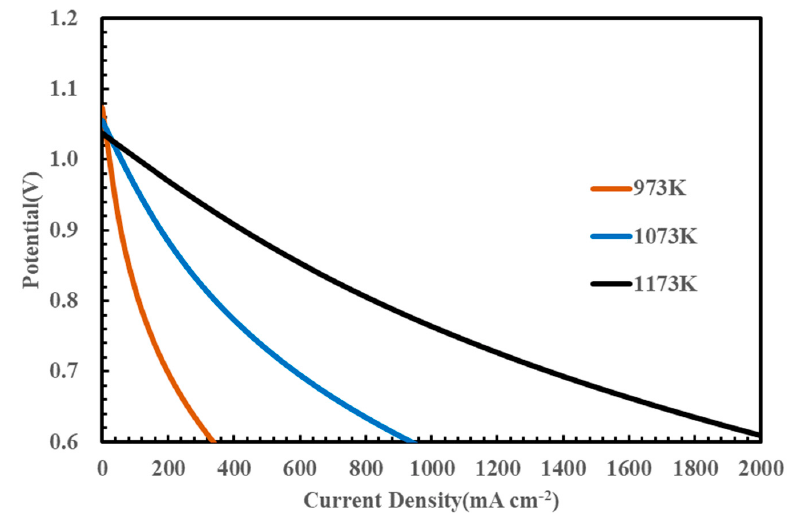
Figure 2. j-V curves of the solid oxide fuel cell at different operating temperatures.